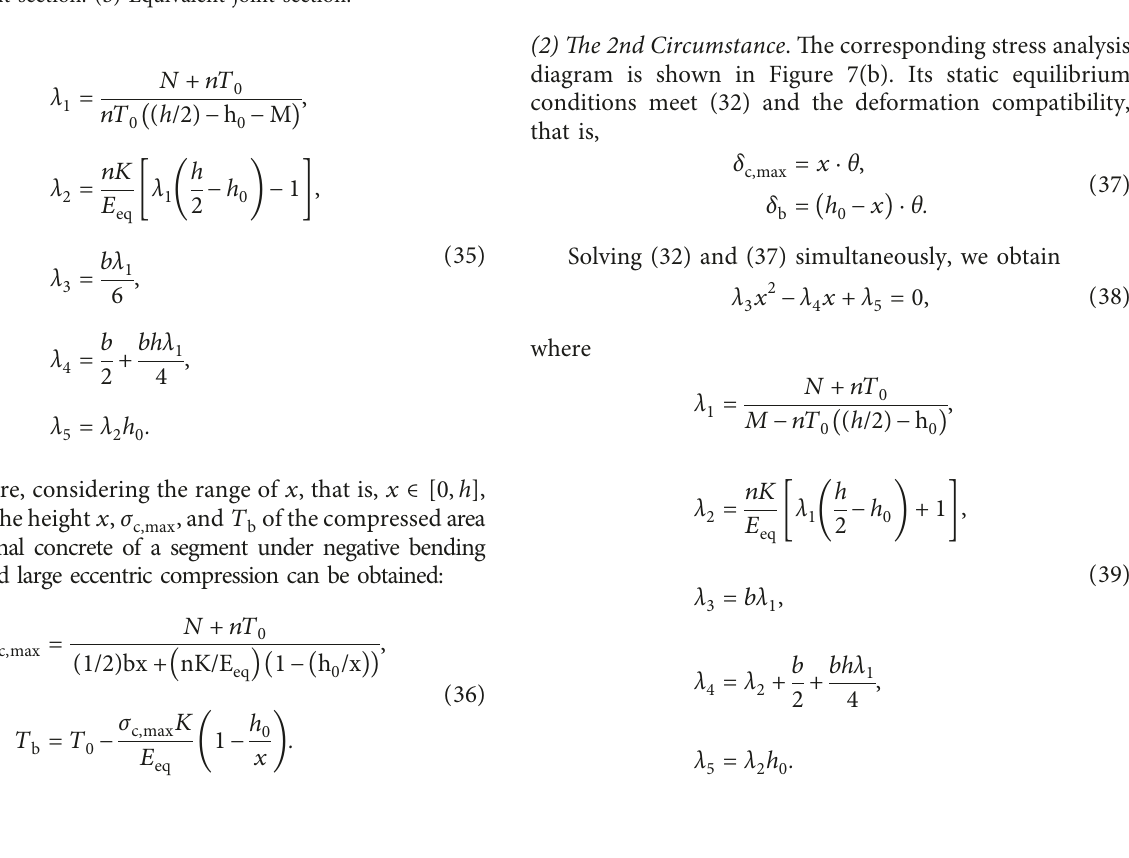
Figure 5: Mechanical characteristic of the joint section under positive bending moment and large eccentricity pressing condition. (a) Original joint section. (b) Equivalent joint